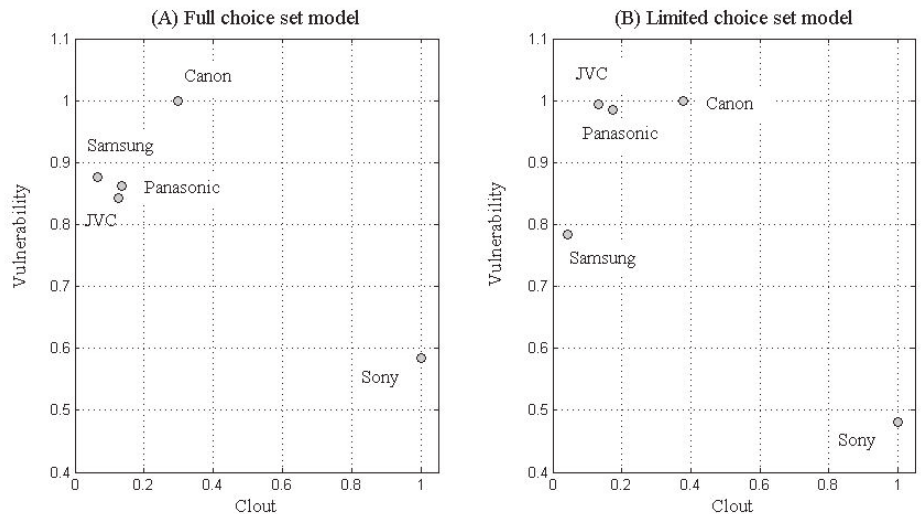
<Figure 5> Clout and vulnerability charts implied by the full consideration set (panel A) and consideration set (panel B) models. Note that all the values are normalized for comparison purposes within charts (A) and